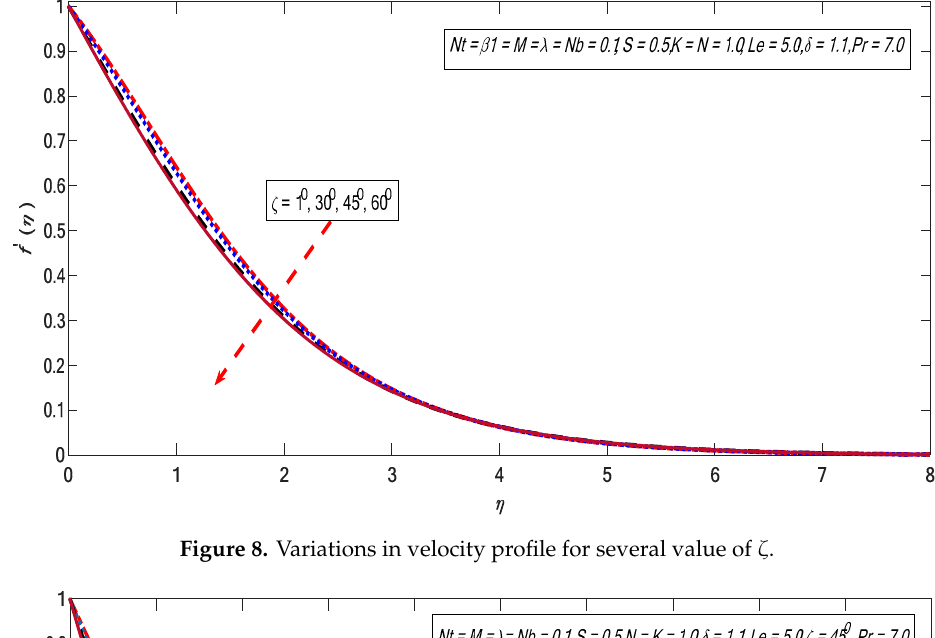
Figure 8. Variations in velocity profile for several value of 𝜁 .